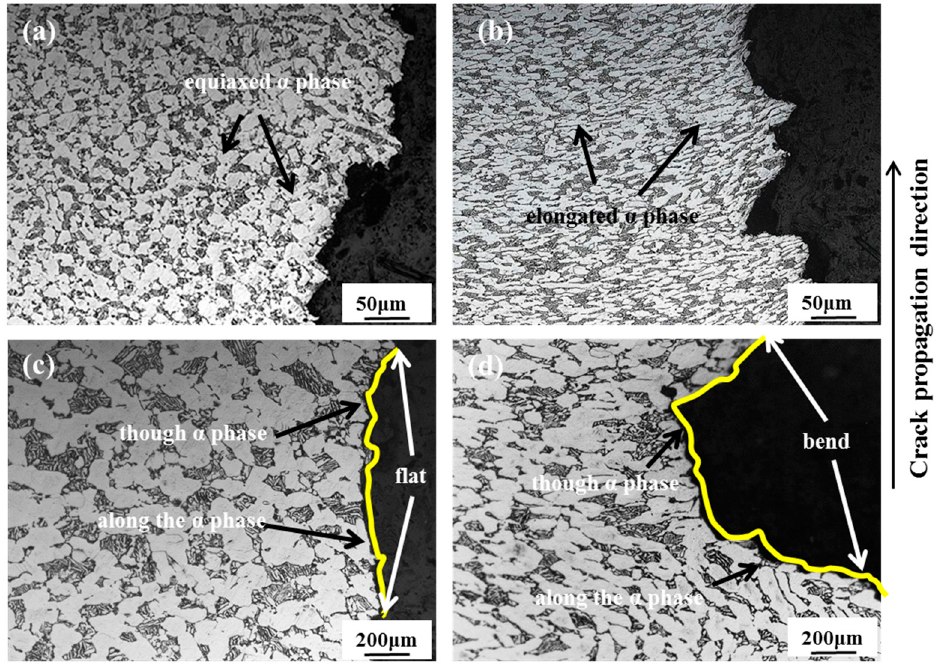
Figure 6. Metallographic microstructure of fractures for different notch orientations: ( a , c ) RD-TD specimen; ( b , d ) RD-ND specimen.